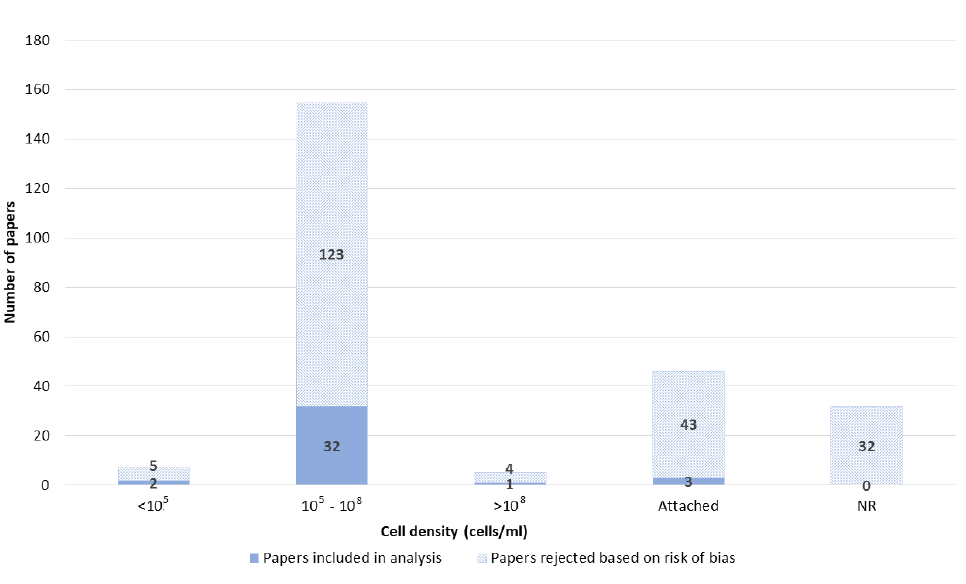
Figure 12. Cell density. NR–not reported.